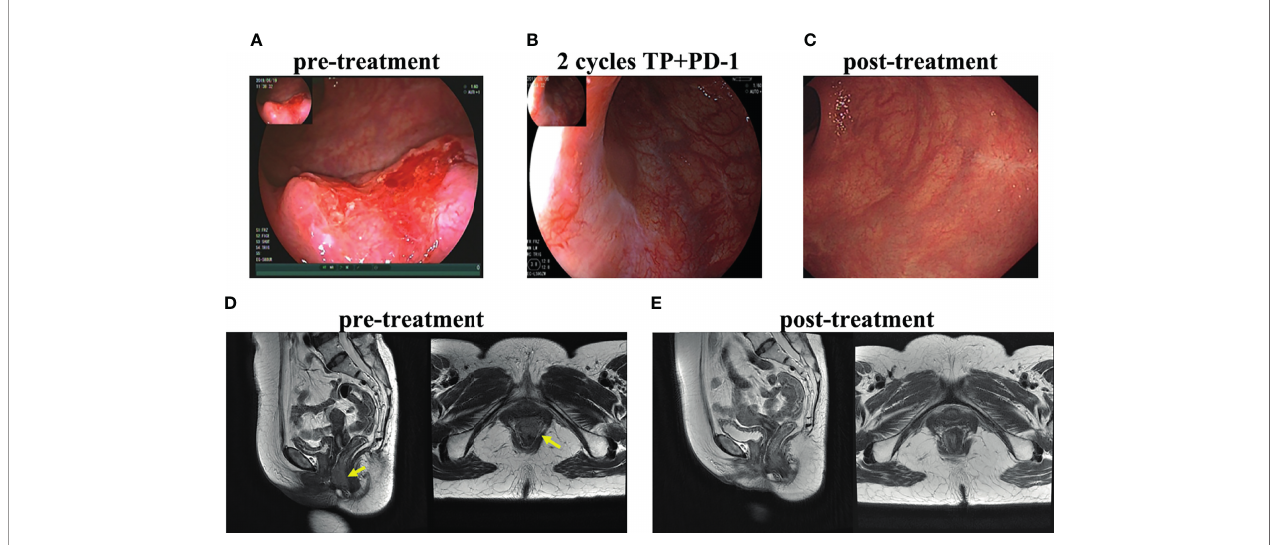
FIGURE 1 | Treatment response of patient 1. Colonoscopy of primary tumor before treatment (A) , after 2 cycles of neoadjuvant toripalimab combined with docetaxol and cisplatin (B) , after radiotherapy and concurrent toripalimab (C) . T2WI MRI image before treatment (D) and after the whole treatment (E)